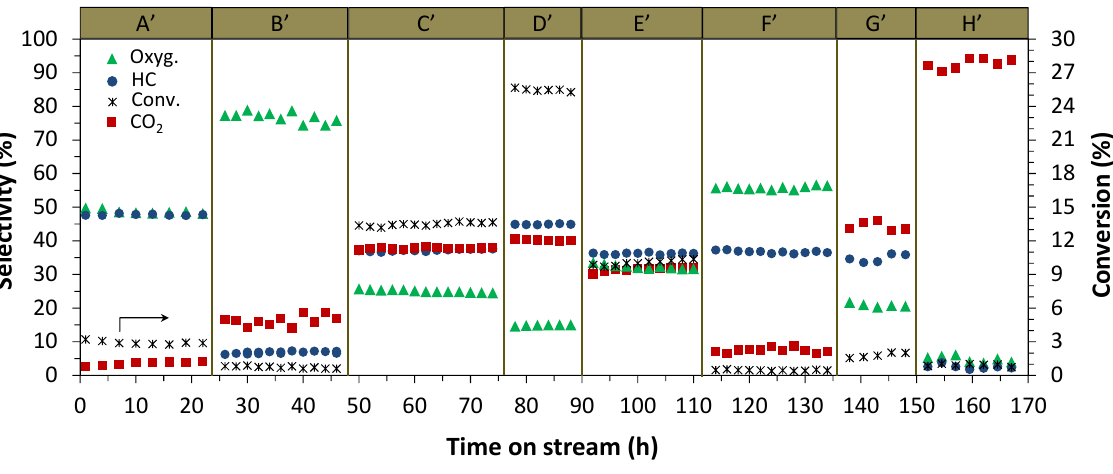
Figure 5. Selectivities and conversion with time on stream for the Rh/MCM-41 catalyst. Oxyg.: alcohols, acetaldehyde, acetic acid and esters. HC: methane and